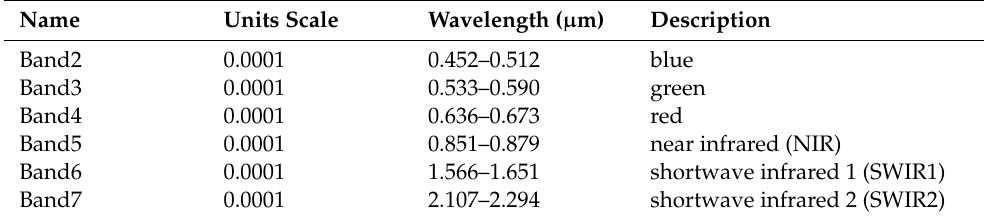
Table 1. Spectral bands of Landsat 8 used for forest tree species